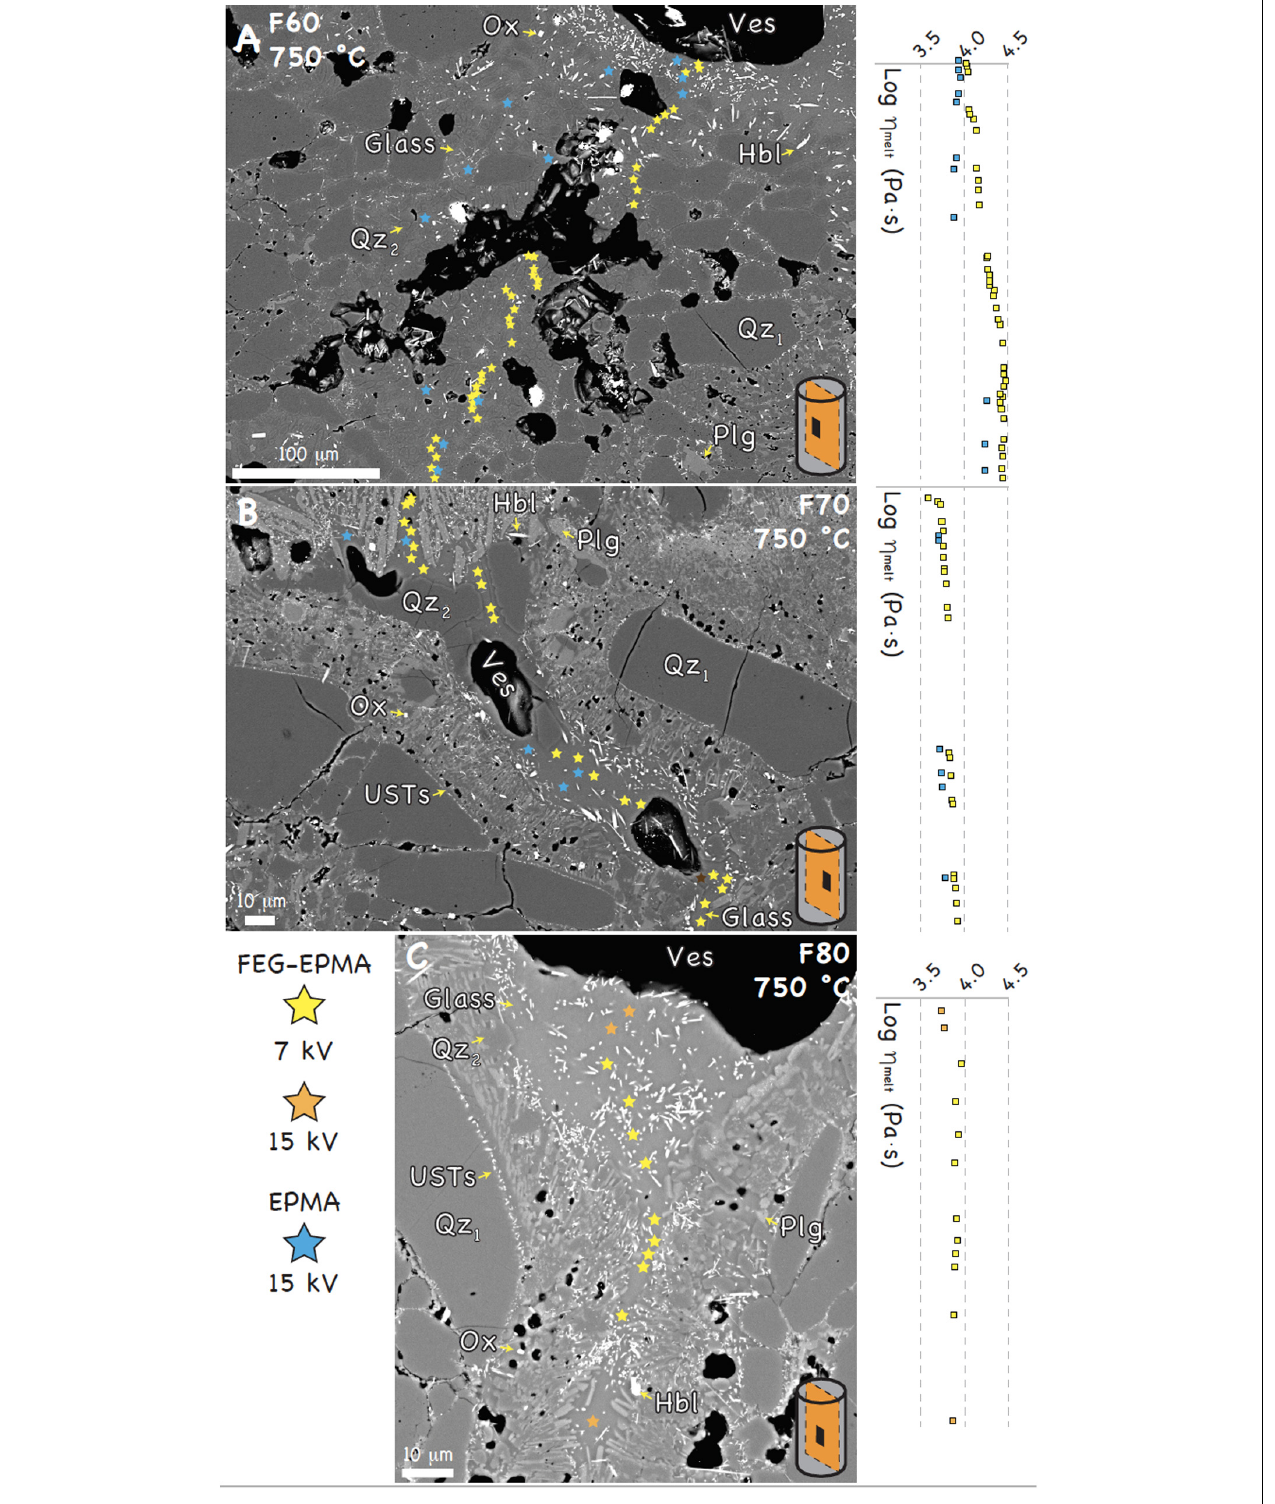
FIGURE 7 | FEG-probe-based BSE images of selected portions within the central polished sections of: (A) F60, (B) F70, and (C) F80 at 750 ◦ C. Error bars corresponding to 2 σ are smaller than symbols. See acronyms from Figures 5, 6 , plus USTs = unidirectional solidification textures, consisting of plagioclase and quartz (Qz 2 ) aligned perpendicular to the surface of the pre-existing quartz minerals (Qz 1 ). Sketches of cylindrical samples (light gray) show the location of the sample portion (black rectangles) inspected in the sample central section (orange plane).